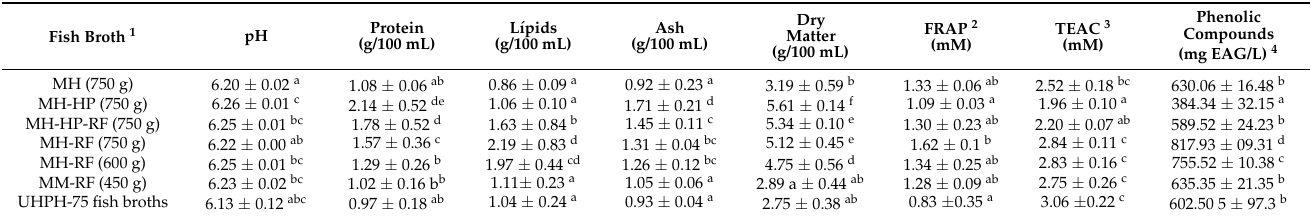
Table 4. Chemical composition, pH, antioxidant capacity (FRAP and TEAC), and phenolic compo- nents of the different fish broth formulations and fish broth ultra-high-pressure-homogenized at 300 MPa at an inlet temperature of 75 ◦